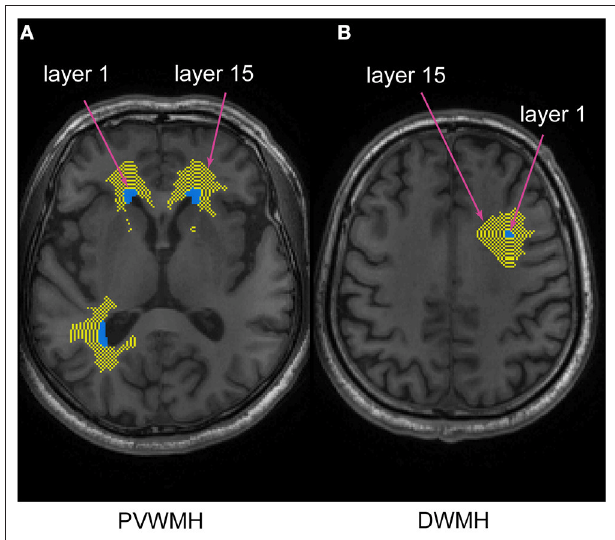
FIGURE 1 | The spatial relationship between PVWMH, DWMH, and their corresponding NAWM layer masks. The turquoise and yellow represent WM lesions and NAWM layers, respectively. The innermost layer surrounding the WMH represents layer 1, and the outermost layer represents layer 15. (A) periventricular white matter hyperintensity (PVWMH); (B) deep white matter hyperintensity (DWMH).